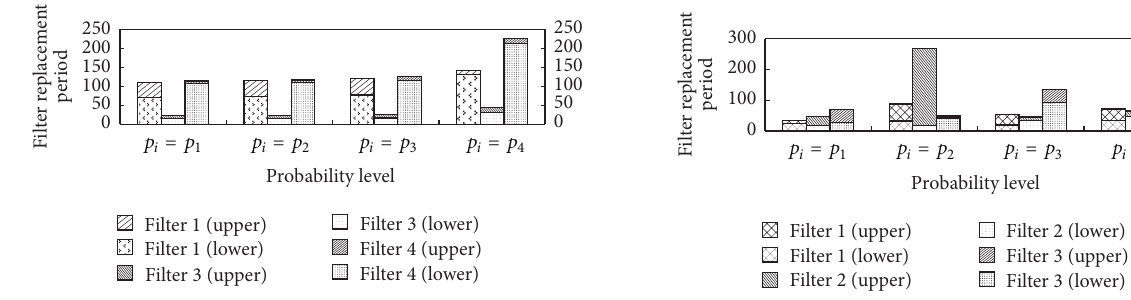
Figure 9: Filter replacement periods for Scenario 5 under high contaminant ingression/generation level.